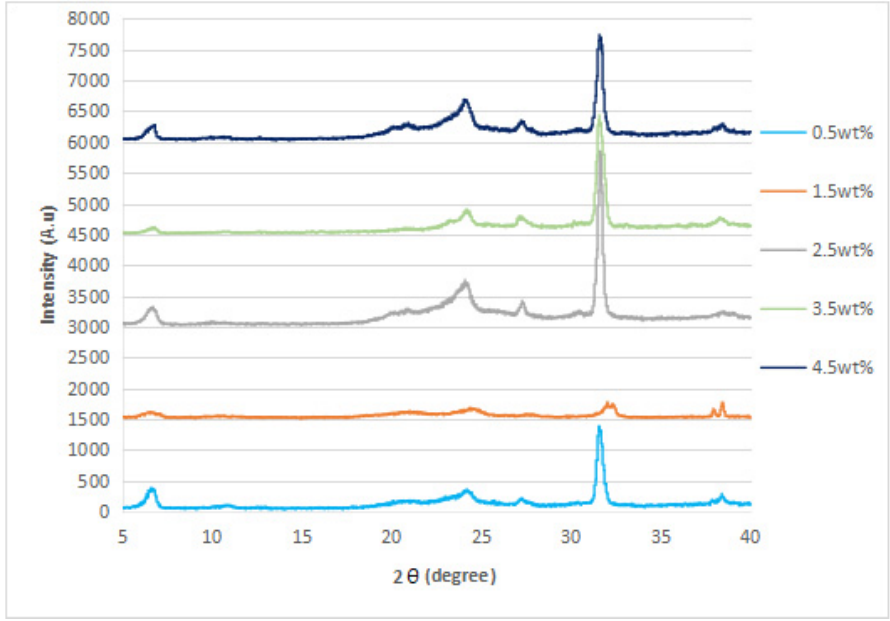
Figure 6. XRD Spectra of Nylon 610 Nanocomposites with Treated Graphite Flakes at 150 °C and − 0.08 MPa .